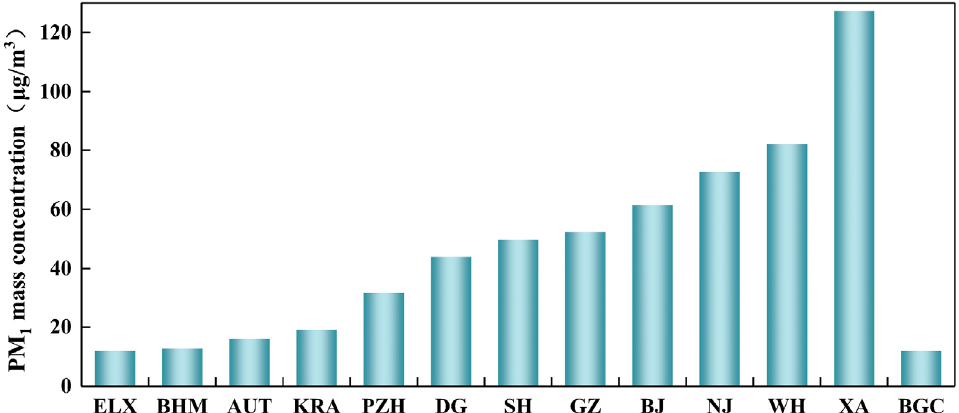
Figure 3. Seasonal distribution characteristics of the PM 1 mass concentrations in Panzhihua (NNP, HMK).